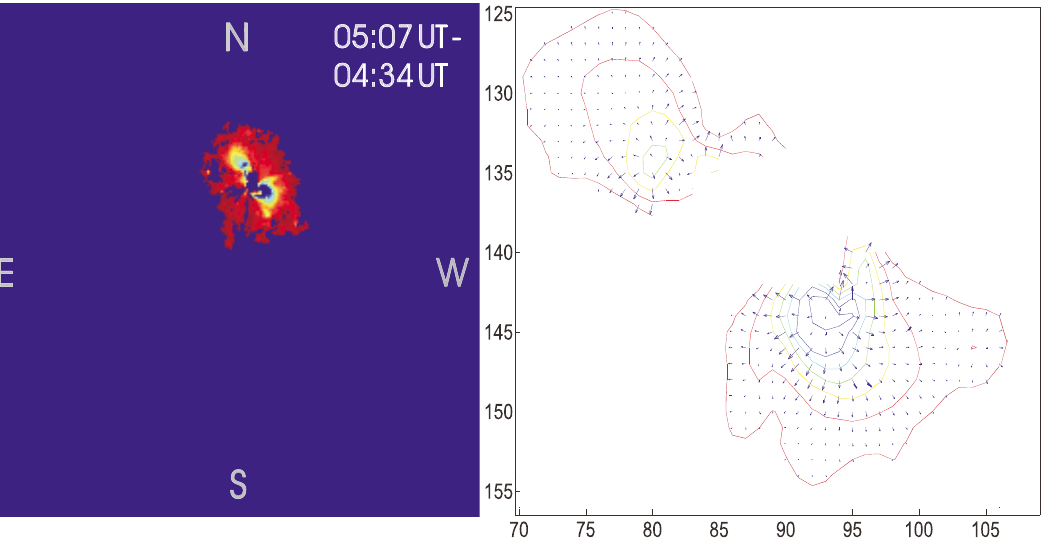
Fig. 7. Left shows extracted dimming. Right panel shows dimming structure map. Lines show equipotential levels of intensity, arrows show the direction of intensity